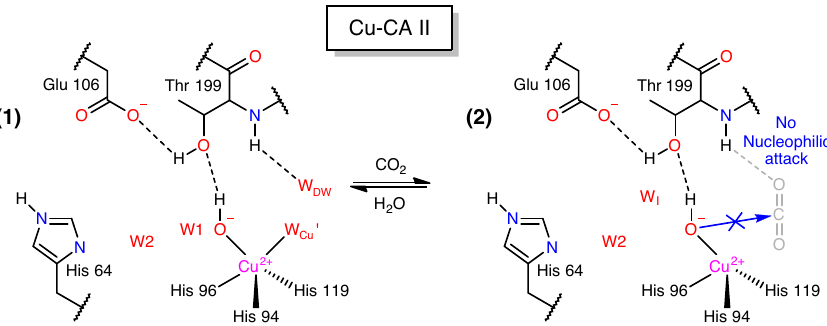
Fig. 9 Proposed catalytic mechanism of Cu-CA II. In Cu-CA II, one of the two bound water molecules in the trigonal bipyramid coordination experiences signi fi cant steric hindrance from CO 2 molecule, hindering adoption of proper con fi guration for nucleophilic attack. In addition, even if CO 2 binds to the active site temporarily, the nucleophilic attack geometry is too distant (3.9 Å) and signi fi cantly distorted (Fig.